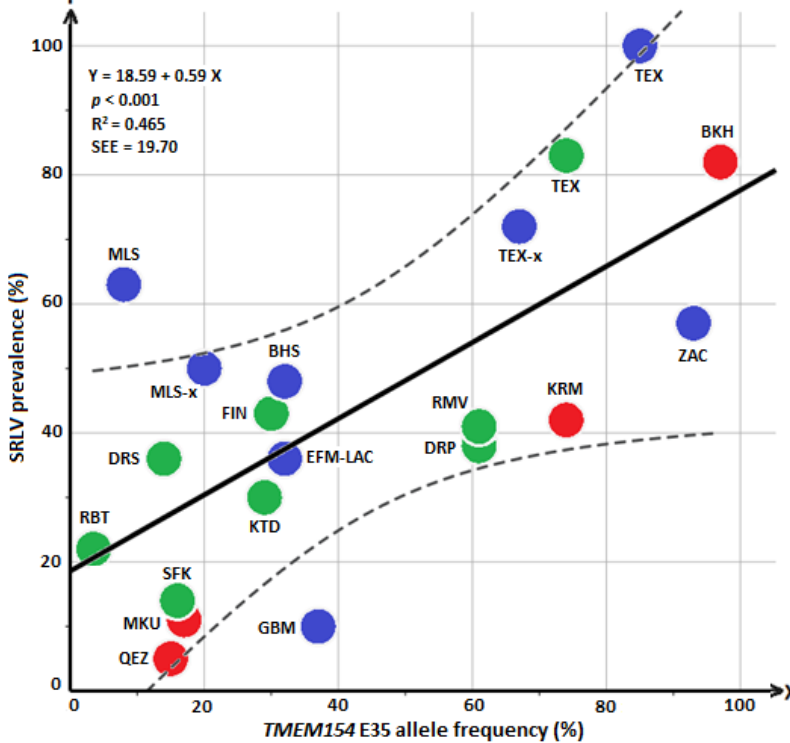
Figure 1. Relationship between TMEM154 E allele frequency (%) and SRLV prevalence (%) in 20 different breeds/flocks from Iran, Germany, and the USA is shown by regression line (black). The dashed lines indicate 99% confidence interval. Sheep breeds/flocks of Iran, Germany, and the USA were labeled with red, blue and green solid colors, respectively. Breed names were abbreviated for Iran (Bakhtiari, BKH; Makouee,